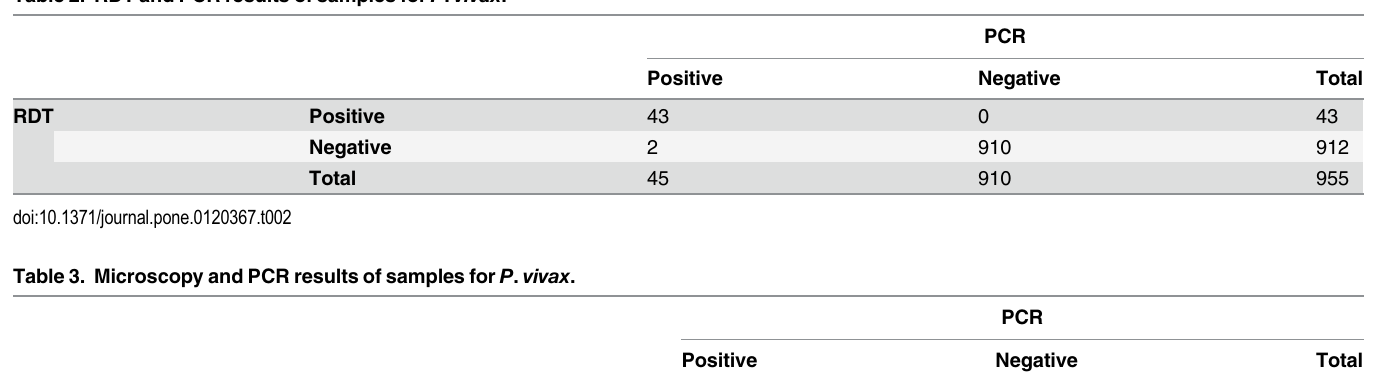
Table 2. RDT and PCR results of samples for P . vivax .